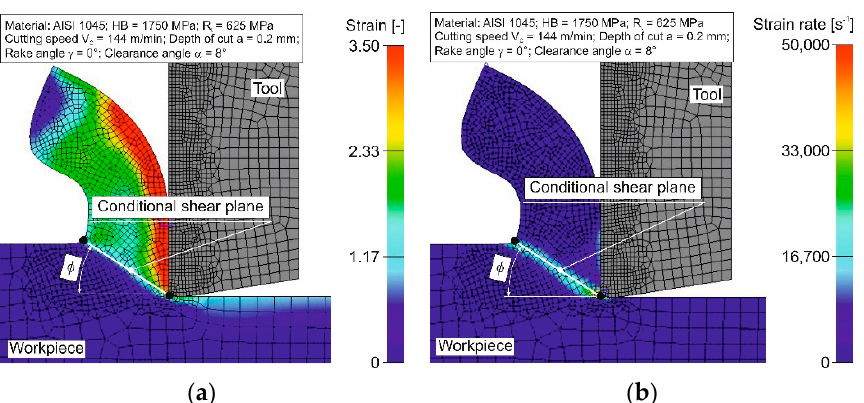
Figure 5. Simulation of strain ( a ) and strain rate distribution ( b ) in the cutting zones of the machined material. chined material.